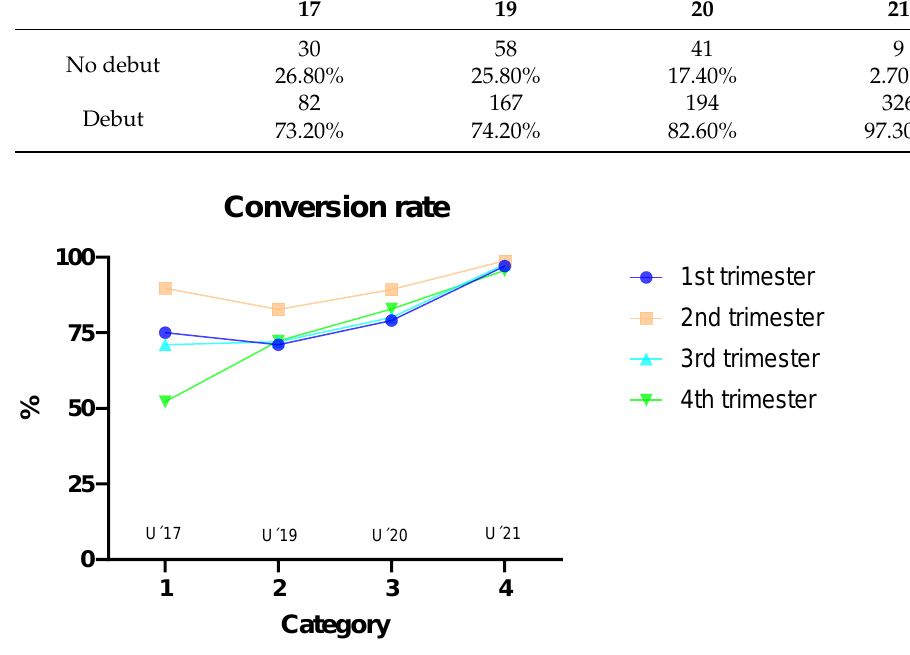
Figure 2. Percentage of players that achieve the professional level according to birth trimester.